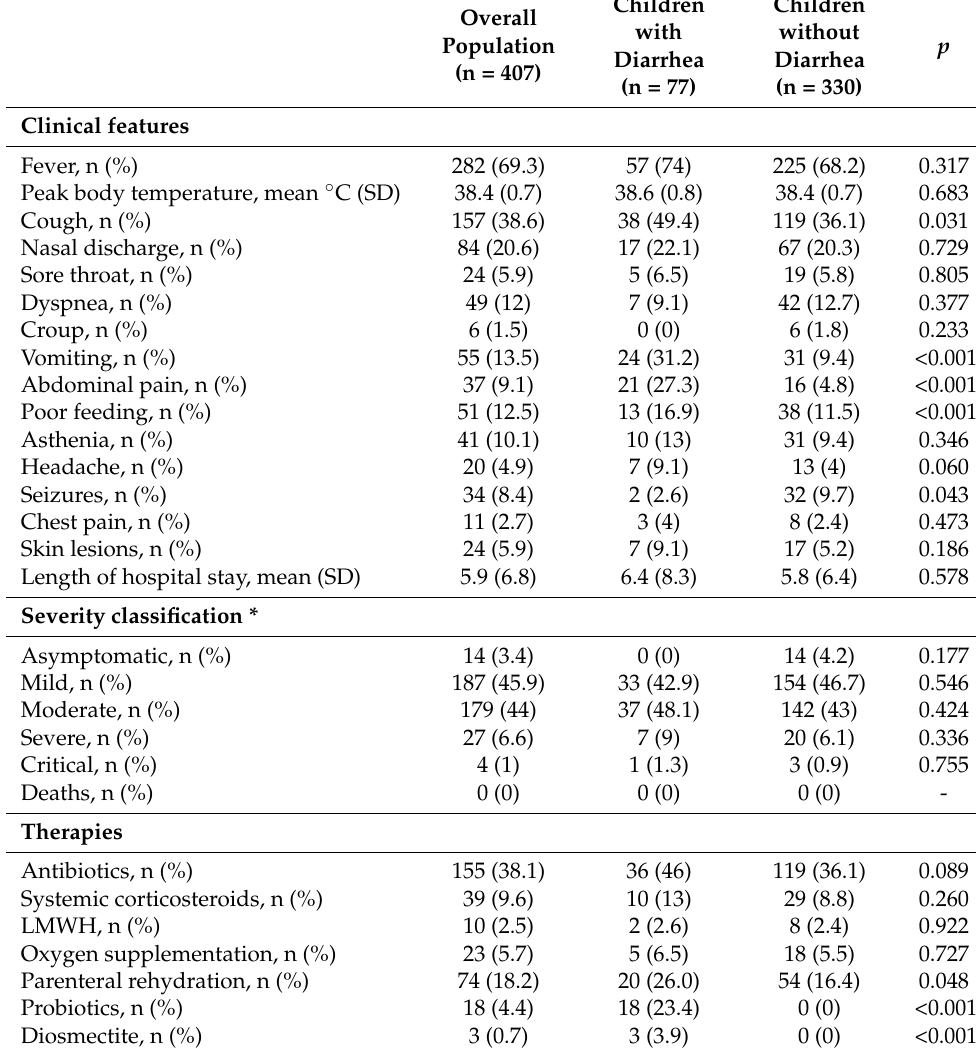
Table 2. Clinical features, severity classification and therapies of enrolled